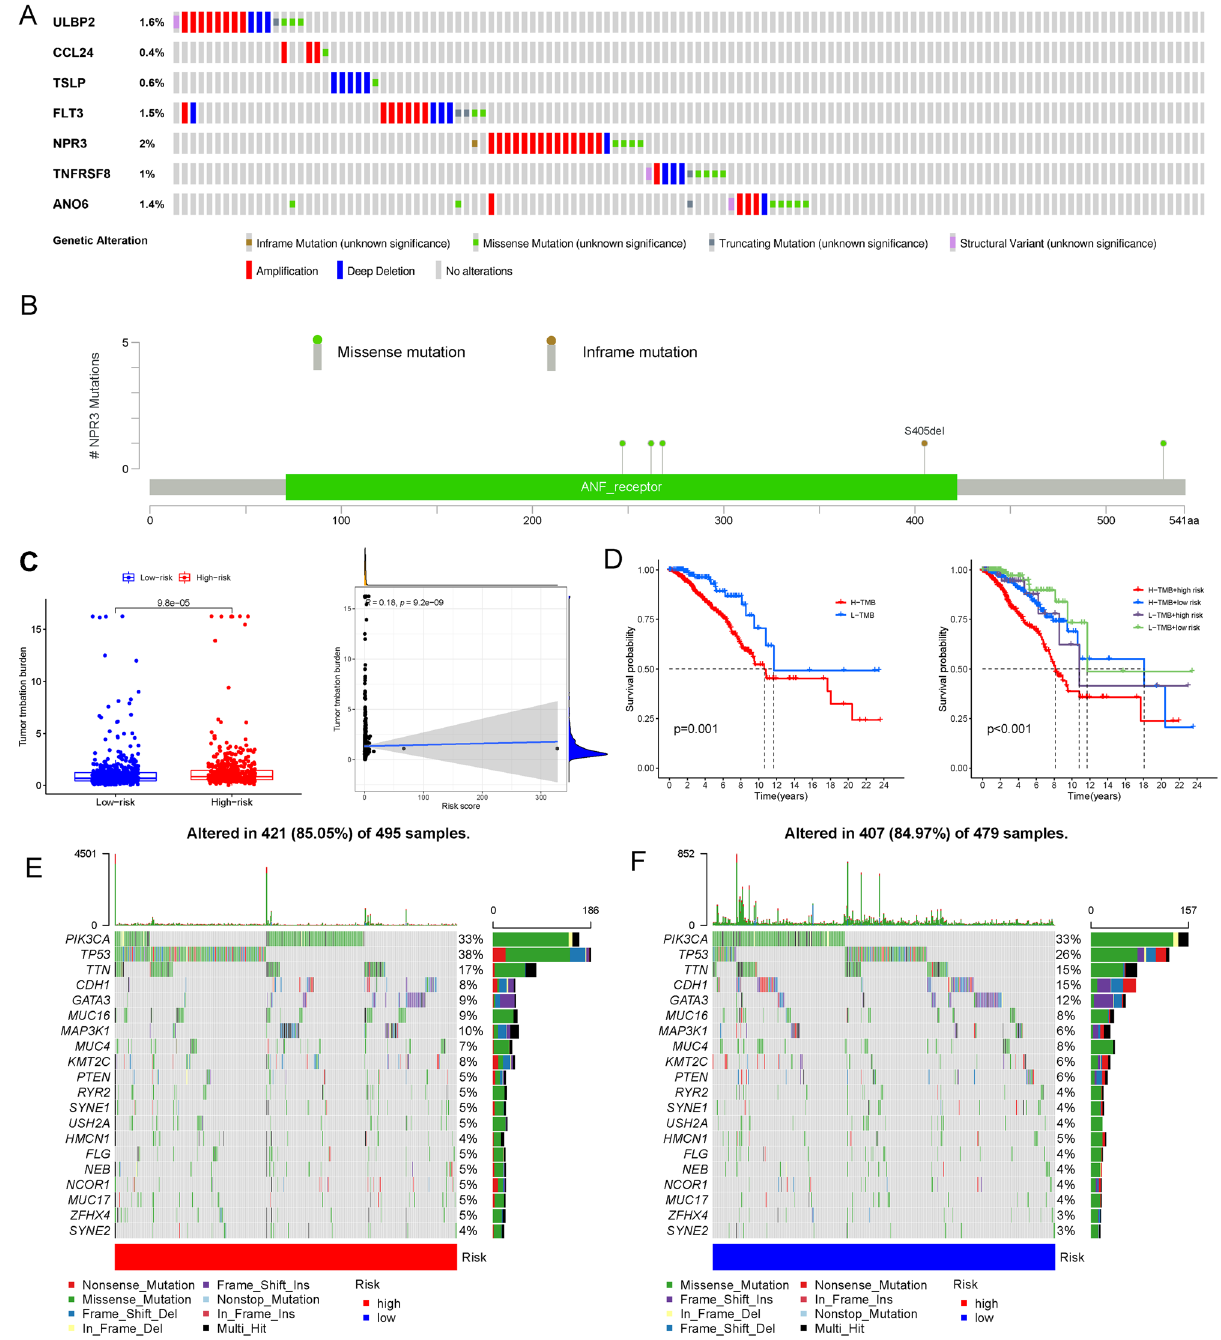
Figure 7. Genetic alteration of immune-related genes (IRGs). In this study, we explored Tumour mutation burden (TMB), somatic mutation, and copy number variations (CNVs) between high- and low-risk groups using the “maftools” R package. Moreover, the cBio Cancer Genomics Portal database (cBioPortal) was performed to assess mutations and CNVs in breast cancer (BC) tissues. ( A ) Analysis of the mutation status of the 7 IRGs in our risk model. ( B ) The most frequent genetic alterations of NPR3 were missense mutation and amplification. ( C ) TMB comparison between the high- and low-risk groups. ( D ) The different survival probabilities for high-risk score BC patients with high TMB and BC patients with both low-risk score and low TMB. ( E ) The mutation frequency and classification of the top 20 gene mutations in the high-risk group. ( F ) The mutation frequency and classification of the top 20 gene mutations in the low-risk group. IRG immune-related gene, TMB tumour mutation burden, CNV copy number variation, cBioPortal cBio Cancer Genomics Portal database, BC breast